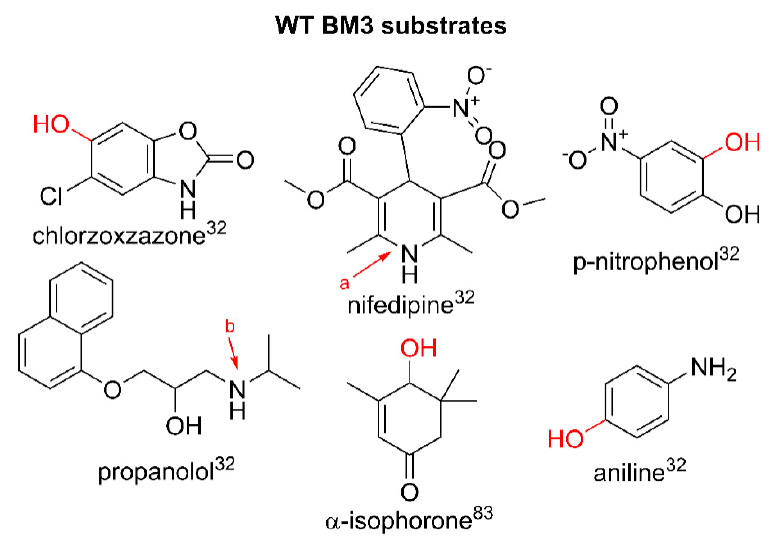
Figure 3. Substrates metabolized by WT BM3. Parent compound structures are in black. Sites of modification are indicated in red: a. aromatization of nifedipine to yield dehydronifedipine, b. dealkylation of propranolol. Literature references are in superscript.